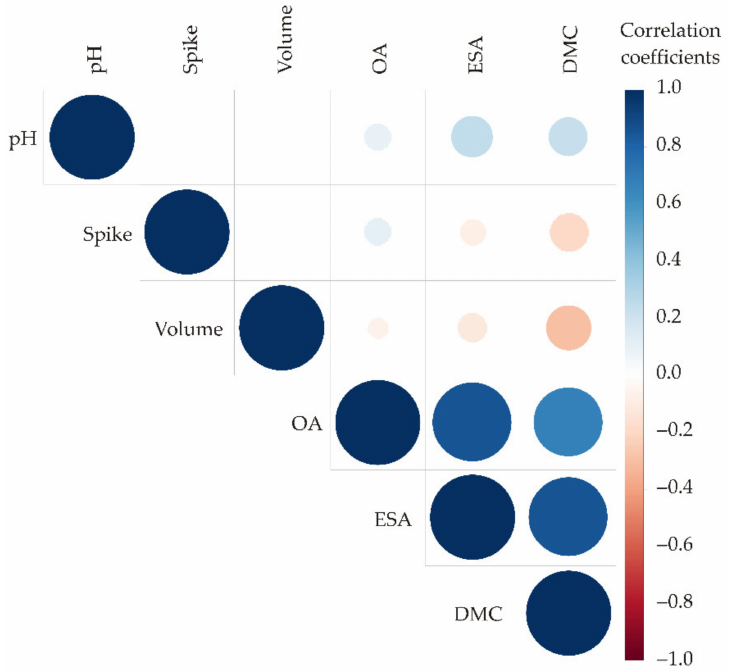
Figure 2. Color correlation diagram between all tested responses. OA—dimethachlor oxalic acid, ESA- dimethachlor ethanesulfonic acid and DMC- dimethachlor.